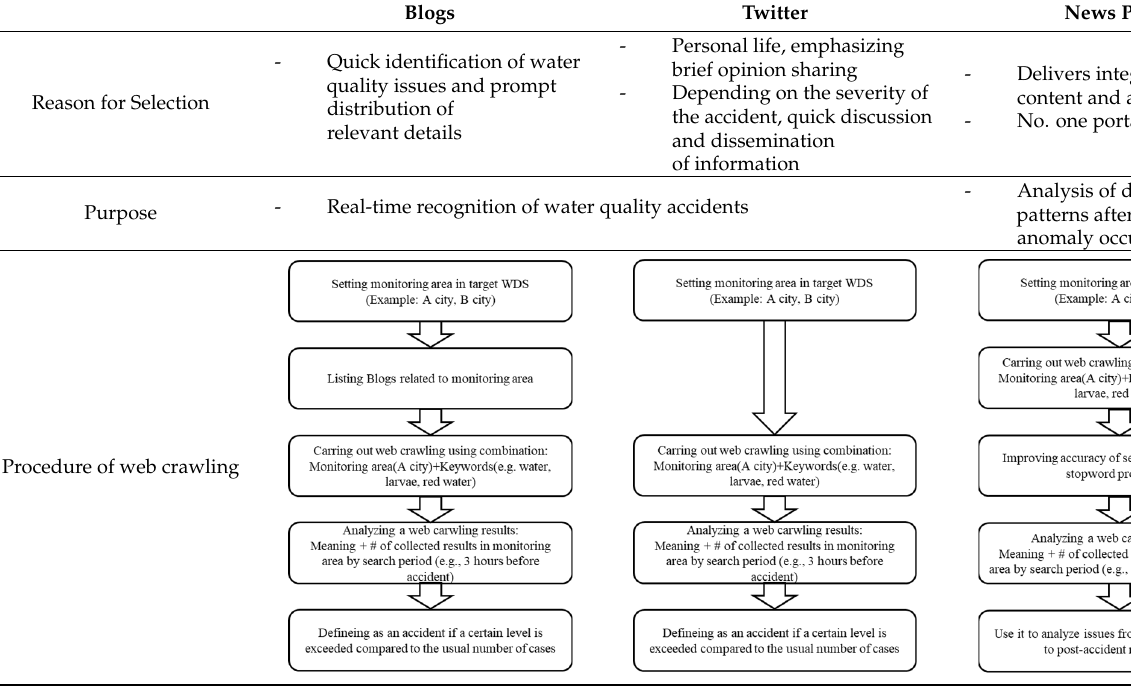
Table 1. Establishing web crawling procedures for each